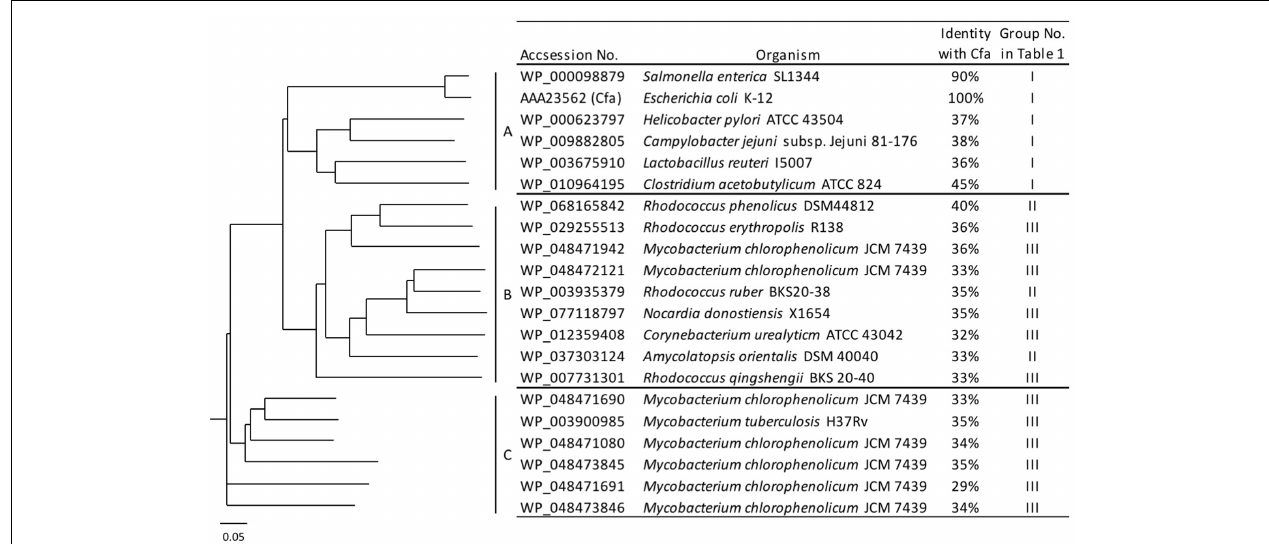
FIGURE 1 | Phylogenetic tree of the S -adenosyl methionine (SAM)-dependent methyltransferases. Amino acid sequences of 21 SAM-dependent methyltransferases from 15 organisms were analyzed and classified into three clades: A, B, and